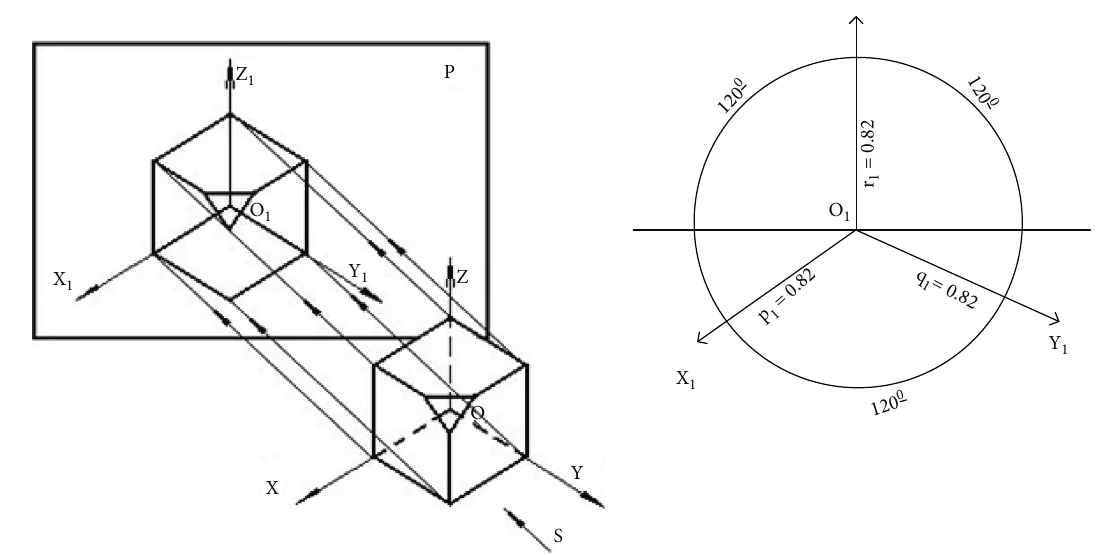
Figure 1: Orthogonal axonometric drawings.